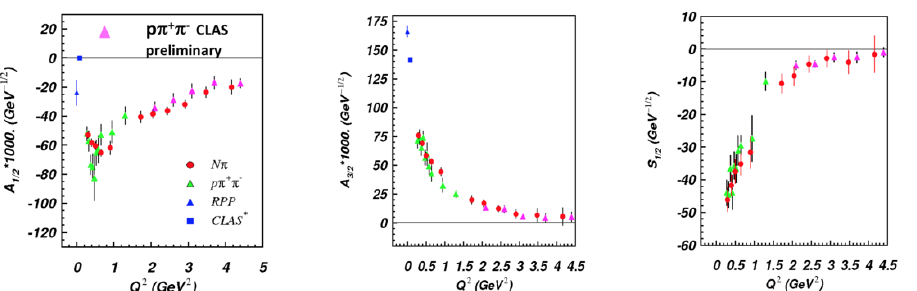
Fig. 6. (Color online) Electromagnetic transition form factors A 1/2 , A 3/2 and S 1/2 of N(1520)3/2 -